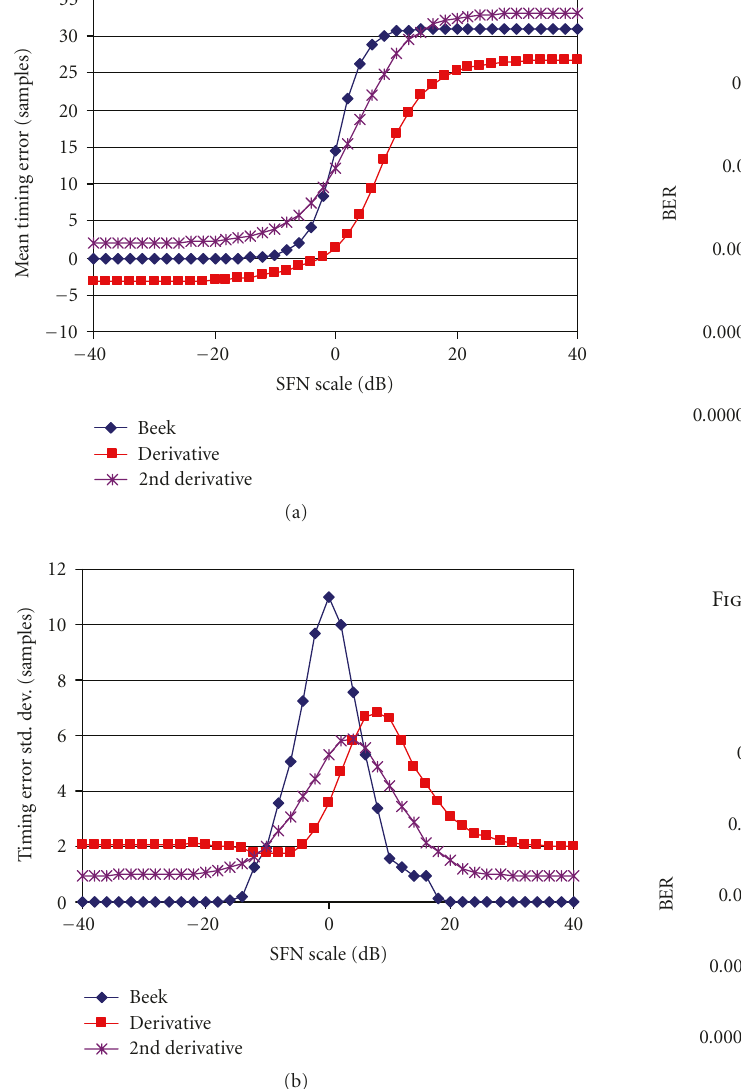
Figure 6: Timing-error performance comparison as a function of SFN power.